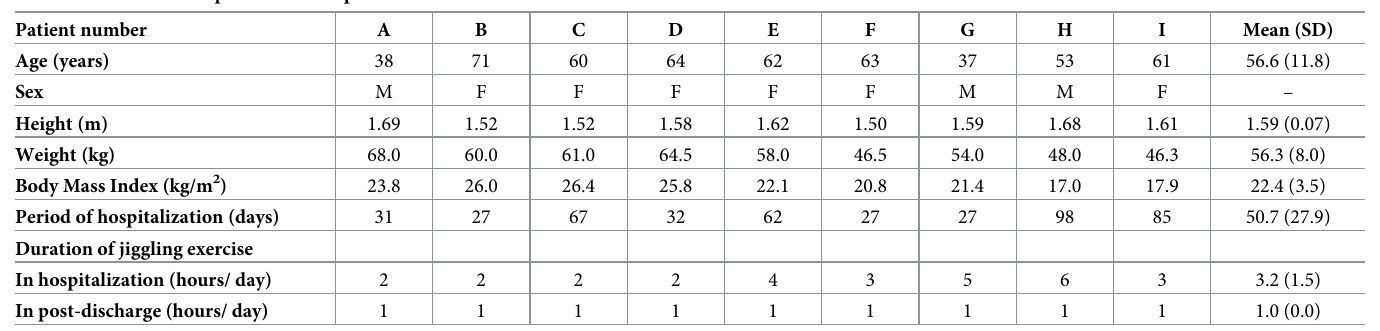
Table 1. Details of nine patients with hip